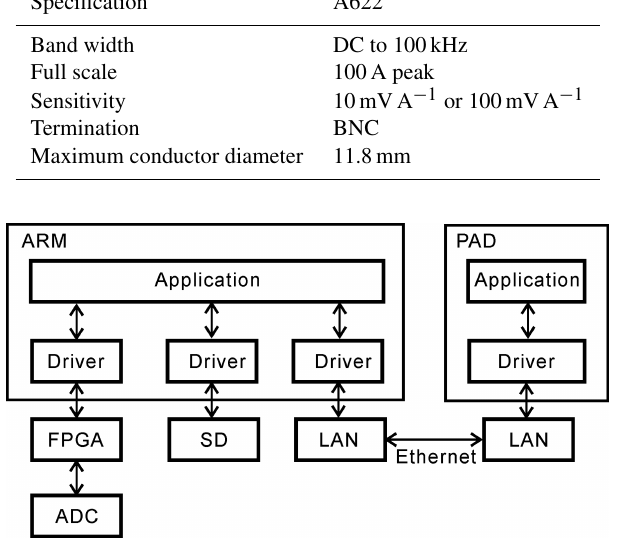
Figure 5. Data flowchart.